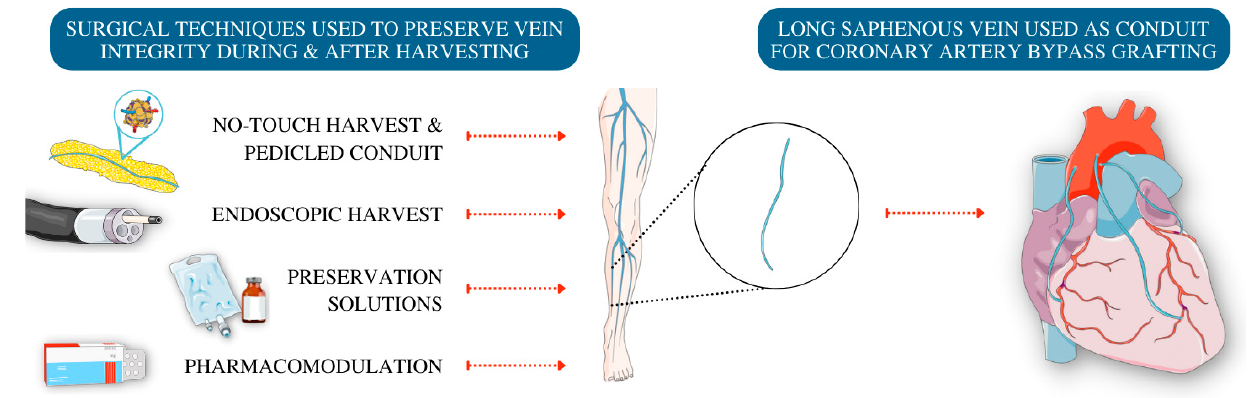
Figure 1. Overview of surgical techniques to preserve vein integrity pre and post harvesting.